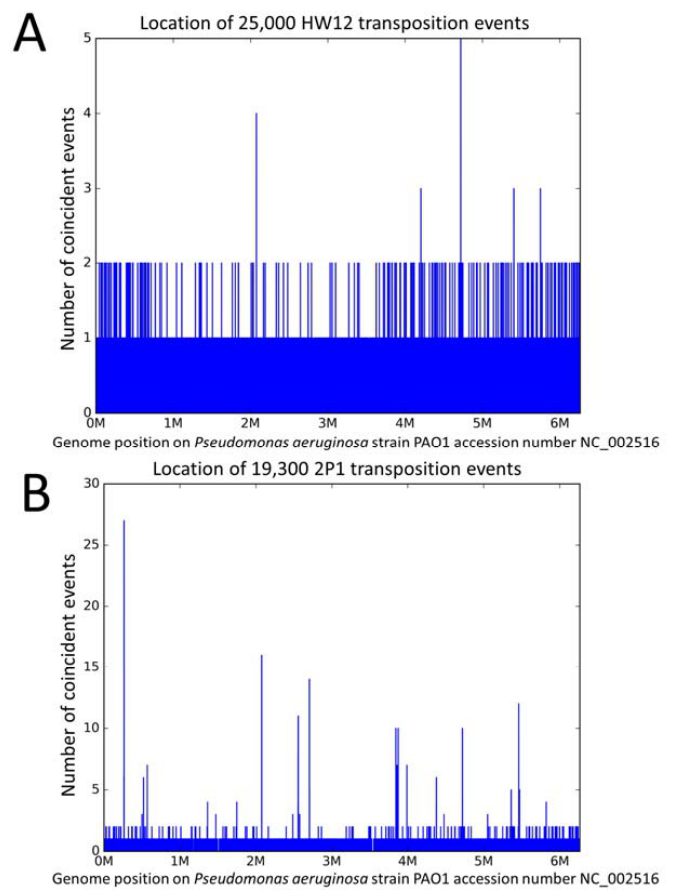
Figure 1. Distribution of transposition sites on Pseudomonas aeruginosa at base ‐ pair resolution. Panel ( A ) The distribution of 25,000 HW12 transposition sites. A maximum of five coincident insertions (one in the reverse orientation and four in the forward orientation) is observed at position 4,720,184. Panel ( B ) The distribution of 19,300 2P1 transposition events. Eight peaks above ten coincident insertions are observed. The tentative HW12 hotspot is one of them. The highest peak corresponds to 27 coincident insertions at positions 265,012–265,013.